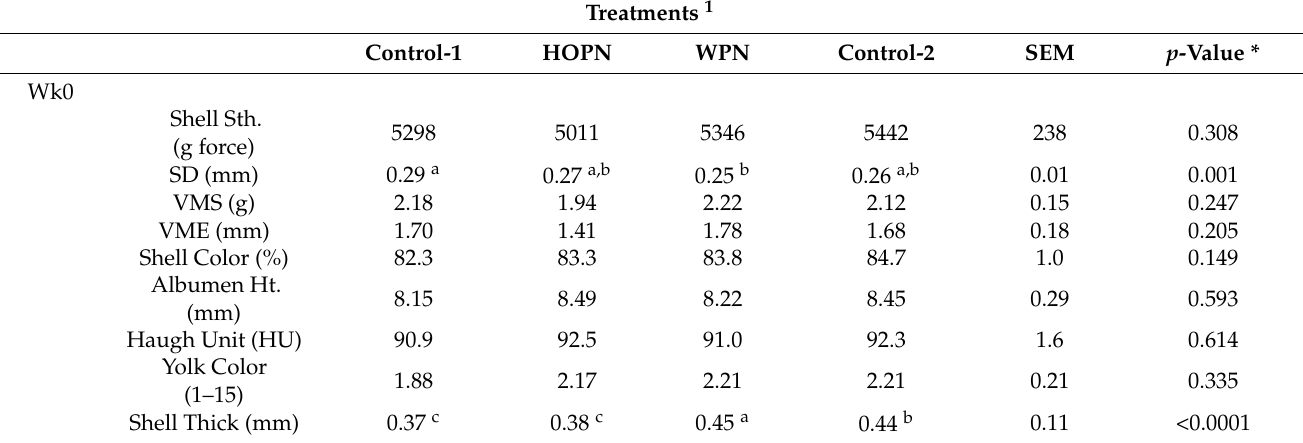
Table 6. Quality of eggs produced per replicate of hens fed a control or peanut-containing